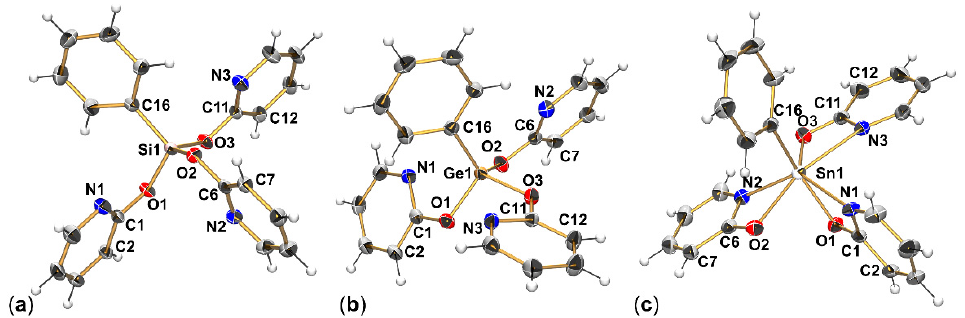
Figure 2. Molecular structures of ( a ) PhSi(pyO) 3 (in the crystal structure of the solvate PhSi(pyO) 3 ·CHCl 3 ), ( b ) PhGe(pyO) 3 , and ( c ) PhSn(pyO) 3 with thermal displacement ellipsoids at the 50% probability level and labels of selected non-hydrogen atoms. Selected interatomic distances (Å) and angles are listed in Table 1. Table 1. Selected interatomic separations [Å] and bond angles [deg] in the tetrel ( E = Si, Ge, Sn) coordination spheres of PhSi(pyO) 3 , PhGe(pyO) 3 and PhSn(pyO) 3 and their pyO ligands.